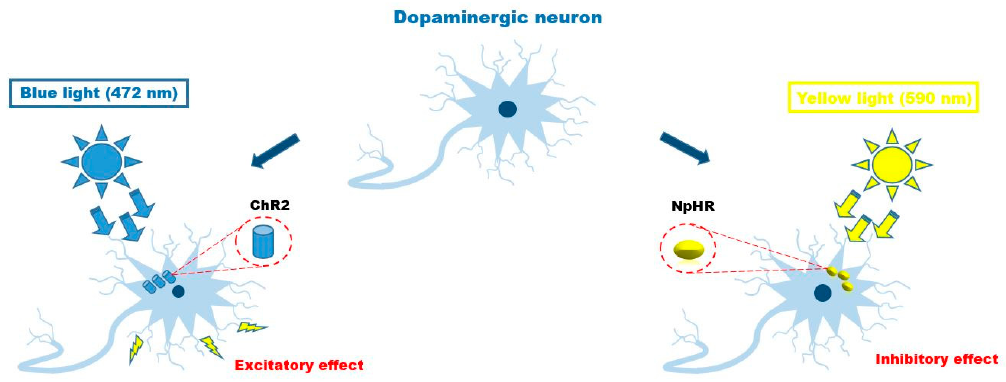
Figure 1. Neuromodulation with Optogenetic technique: blue light activates ChR2 with an excitatory effect, while yellow light activates NpHR with an inhibitory effect.